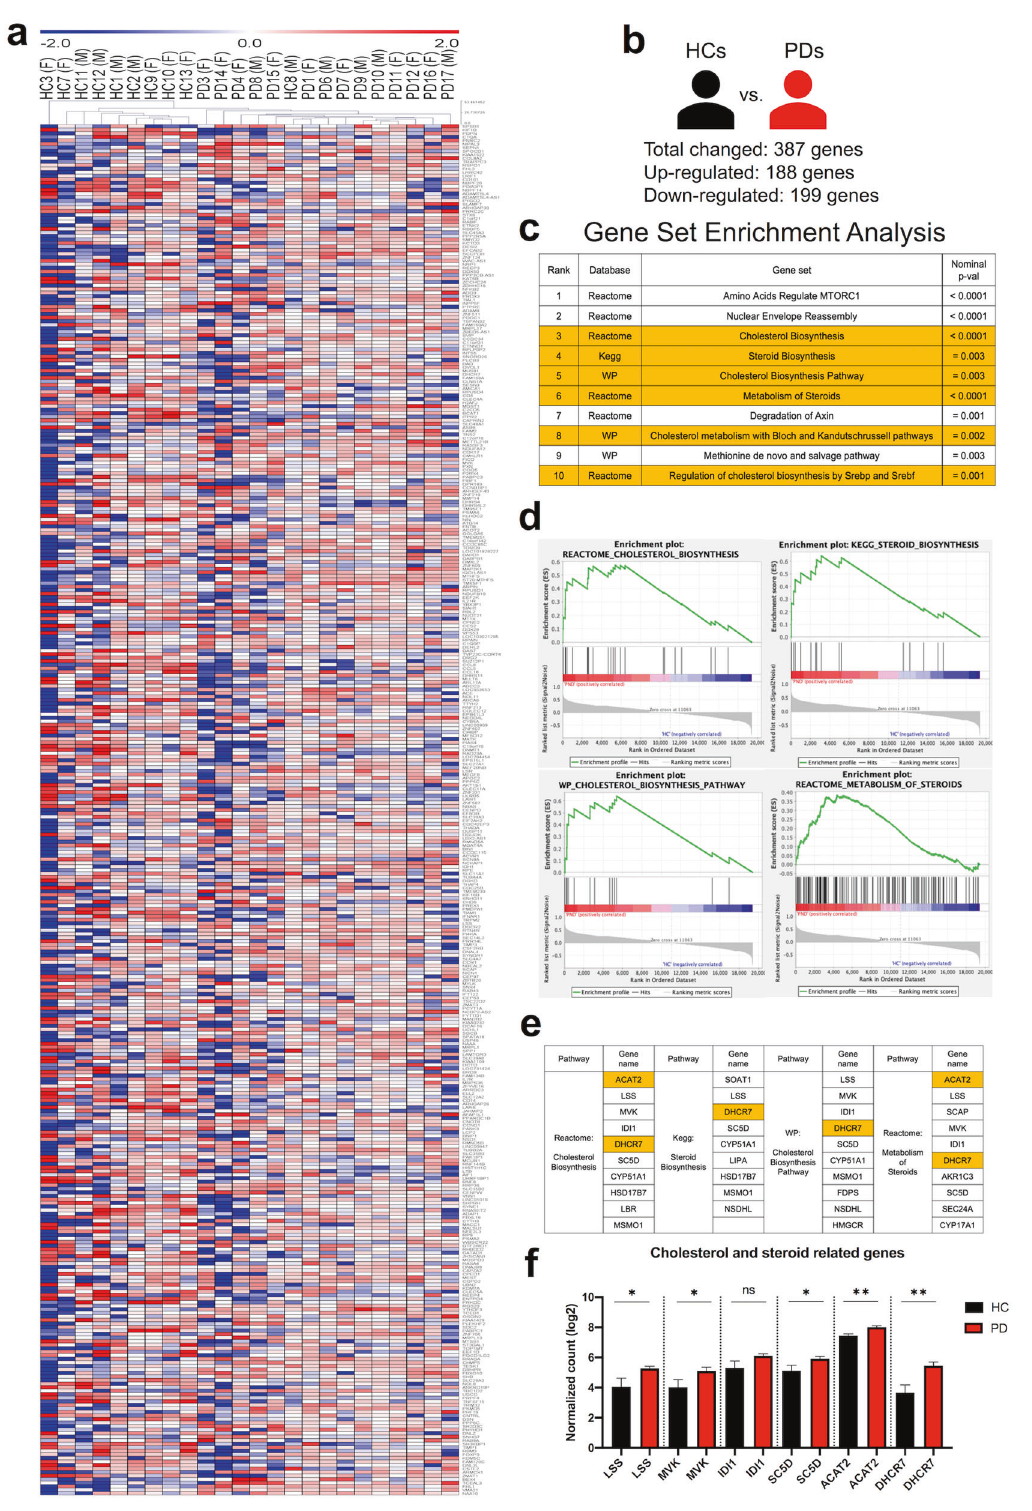
Fig. 3 Transcriptome analysis of PD-iMGs. a Hierarchical clustering and heatmap of differentially expressed genes between HC- and PD- iMGs. Fold change >1.5, P -value <0.05. b Graphical index of the number of differentially expressed genes between HC- and PD-iMGs. c The top 10 enriched pathways are annotated among databases. Cholesterol and steroid biosynthesis pathways were highlighted in orange color. d The top four gene set enrichment plots in GSEA rank. e Core genes are enriched in the top four pathways. The overlapped genes among pathways are shown in orange color. f Unpaired t test of logarithmic normalized read count of overlapped genes between HCs and PDs. To compare statistical signi fi cance between the two groups, we conducted an unpaired t test. * P < 0.05, and ** P <